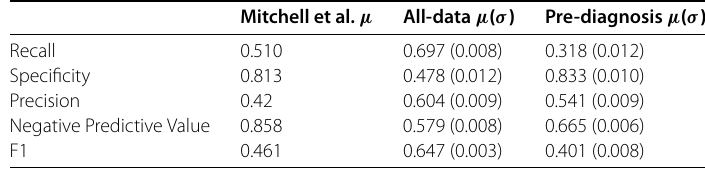
Table 1 Comparison of accuracy metrics for All-data and Pre-diagnosis model